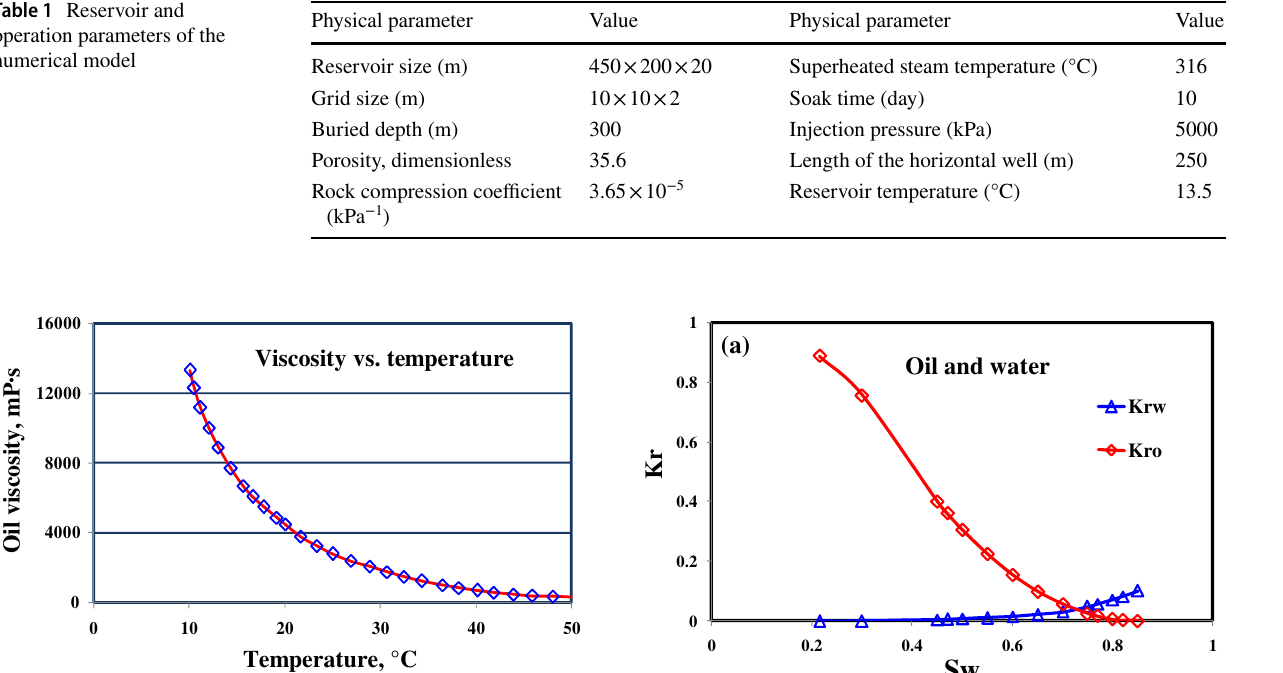
Table 1 Reservoir and